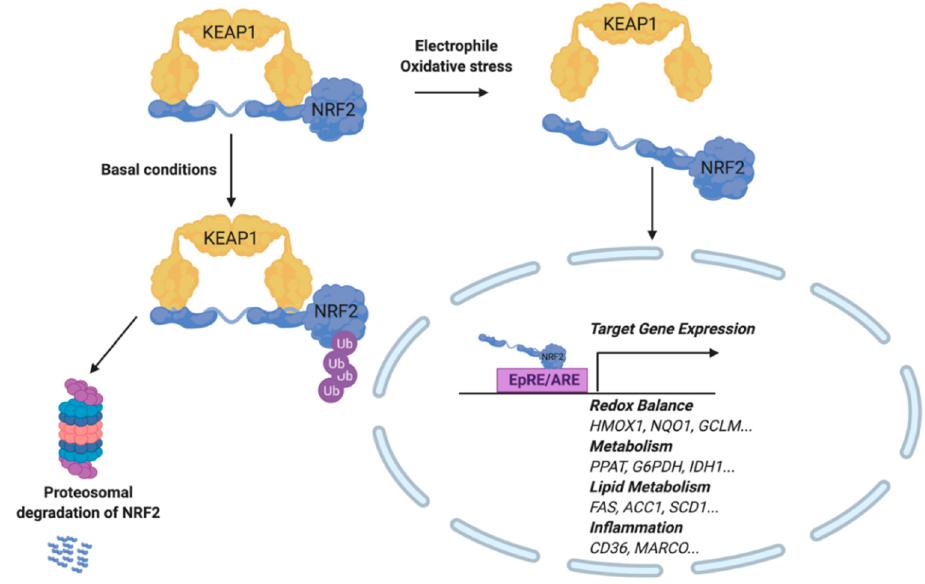
Figure 4. Activation of the Electrophilic Response Element / Antioxidant Response Element (EpRE / ARE). During oxidative stress or exogenous addition of an electrophile, NRF2 is released from its cytosolic binding partner, KEAP1. NRF2 translocates to the nucleus, where it binds to the Antioxidant Response Element (ARE) and induces target gene expression. Target genes include those involved in redox balance, metabolism, lipid metabolism, and inflammation. Under basal conditions, NRF2 remains bound to KEAP1, while subsequently experiencing ubiquitinylation and proteasomal degradation.